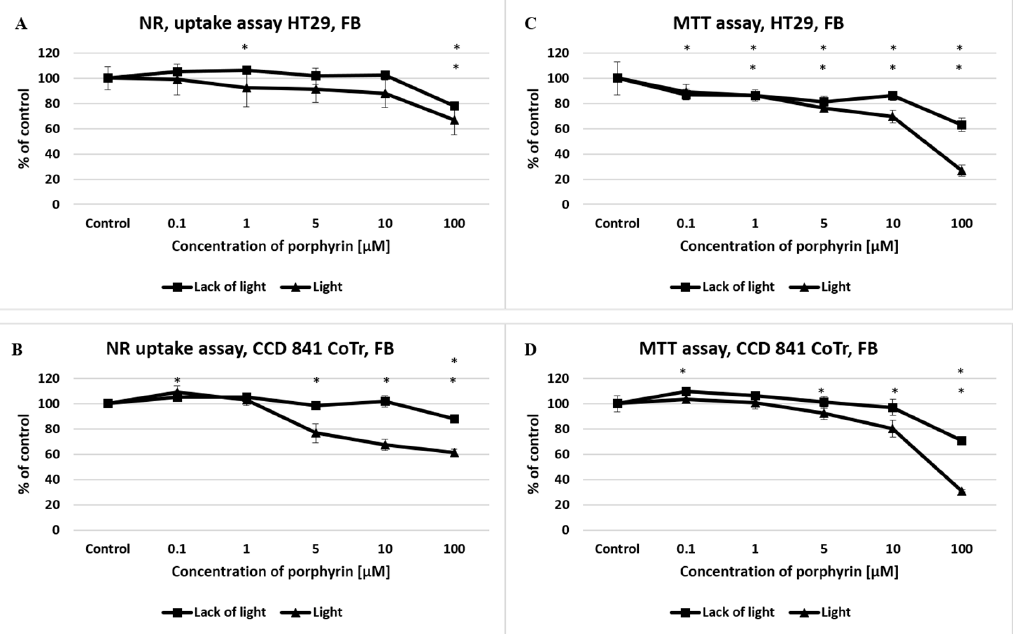
Figure 3. The effect of free-base porphyrin (FB) on viability and mitochondrial metabolism of the HT29 cell line (A, C) and CCD 841 CoTr cells (B, D) after light induction and the absence of light. The neutral red (NR) uptake assay (A, B) and the MTT test (C, D). The results are presented as a percentage of the controls, arbitrarily set to 100%. The figures show averages of three independent experiments. * - Statistical significance was analyzed at p ≤ 0.05. Table 1. EC50 values obtained after 24 h incubation of human colon tumor cell (HT29) and human normal colonic epithelial cell (CCD 841 CoTr) with manganese porphyrin (Mn) and free-base por- phyrin (FB) after light induction and in the absence of light (MTT and neutral red analysis). Statis- tical significance was analyzed at p < 0.05.